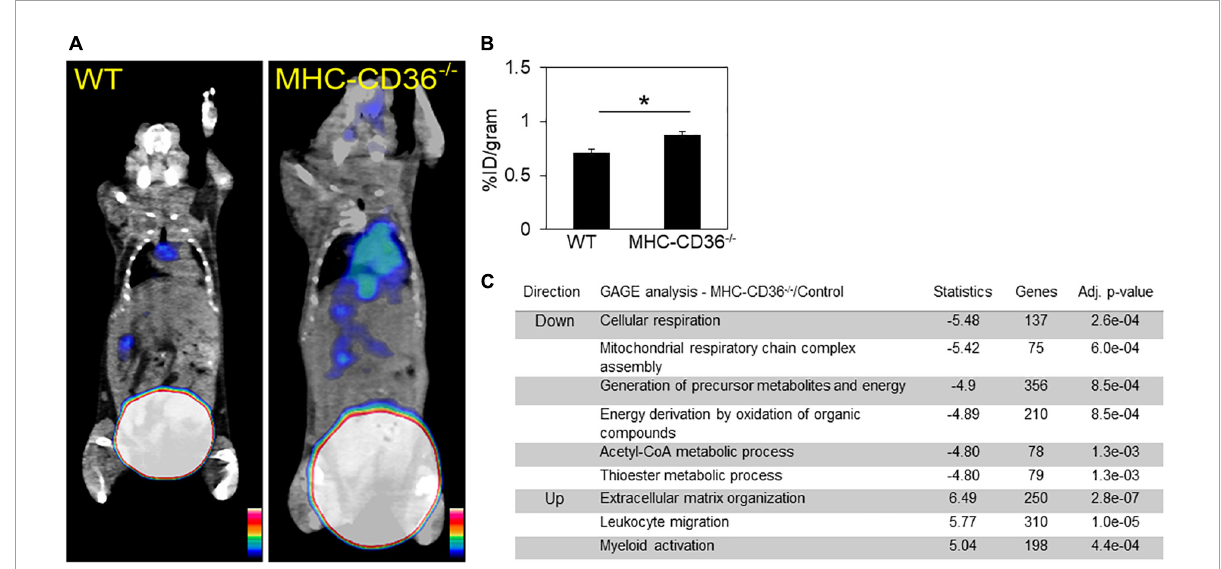
FIGURE7 Myocardial CD36 deletion associates with cardiac inflammation and impaired FA metabolisms. (A,B) Representative 68 Ga-DOTA-ECL1i PET/CT images and quantitative analysis showed higher tracer accumulation in the heart of MHC-CD36 − / − ( n = 4/group) compared with those isolated from control mice ( n = 5/group). Data are means ± SE with n representing the number of mice per group, * p < 0.05. (C) Gene expression of MHC-CD36 − / − and control hearts obtained by RNA-seq. Up- and downregulated biological pathways from Reactome analysis using differentially regulated genes (MHC-CD36 − / − vs. WT, > 1.6 or < 0.7-fold change). All data are ( n = 3/group) with n representing the number of mice per group. Number of genes on the differentially regulated list is indicated on significance bar for each